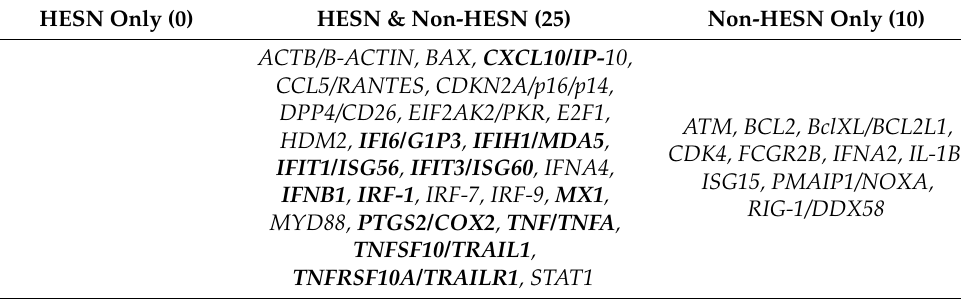
Table 3. Expression of ISGs in unstimulated HESN versus non-HESN PBMC a .